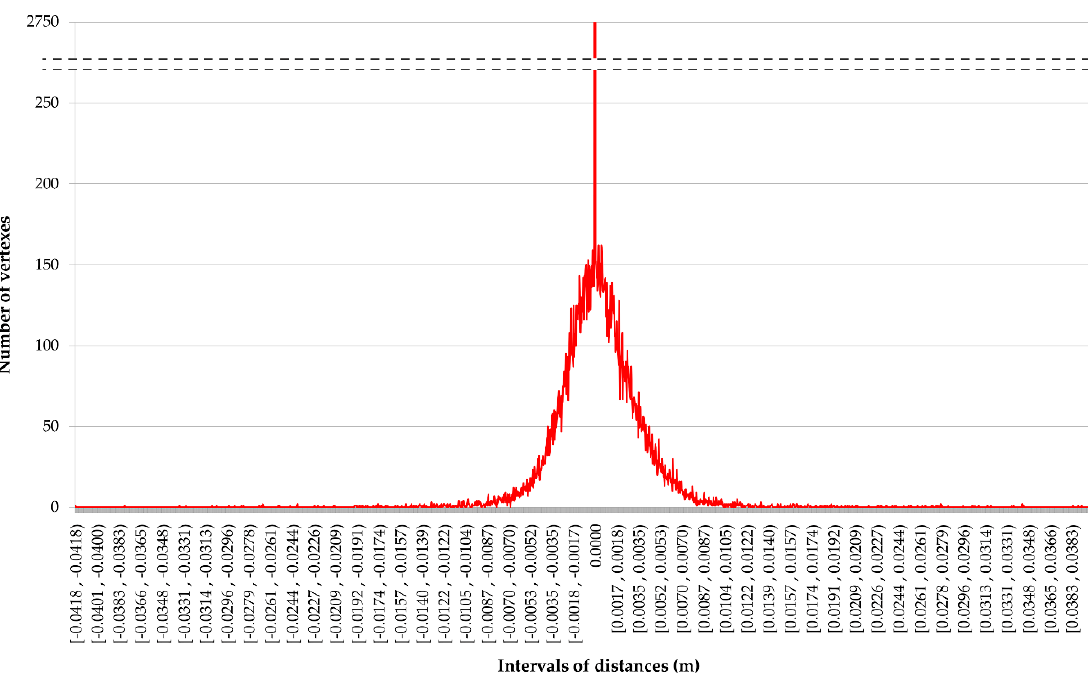
Figure 17. High-resolution texture creation.